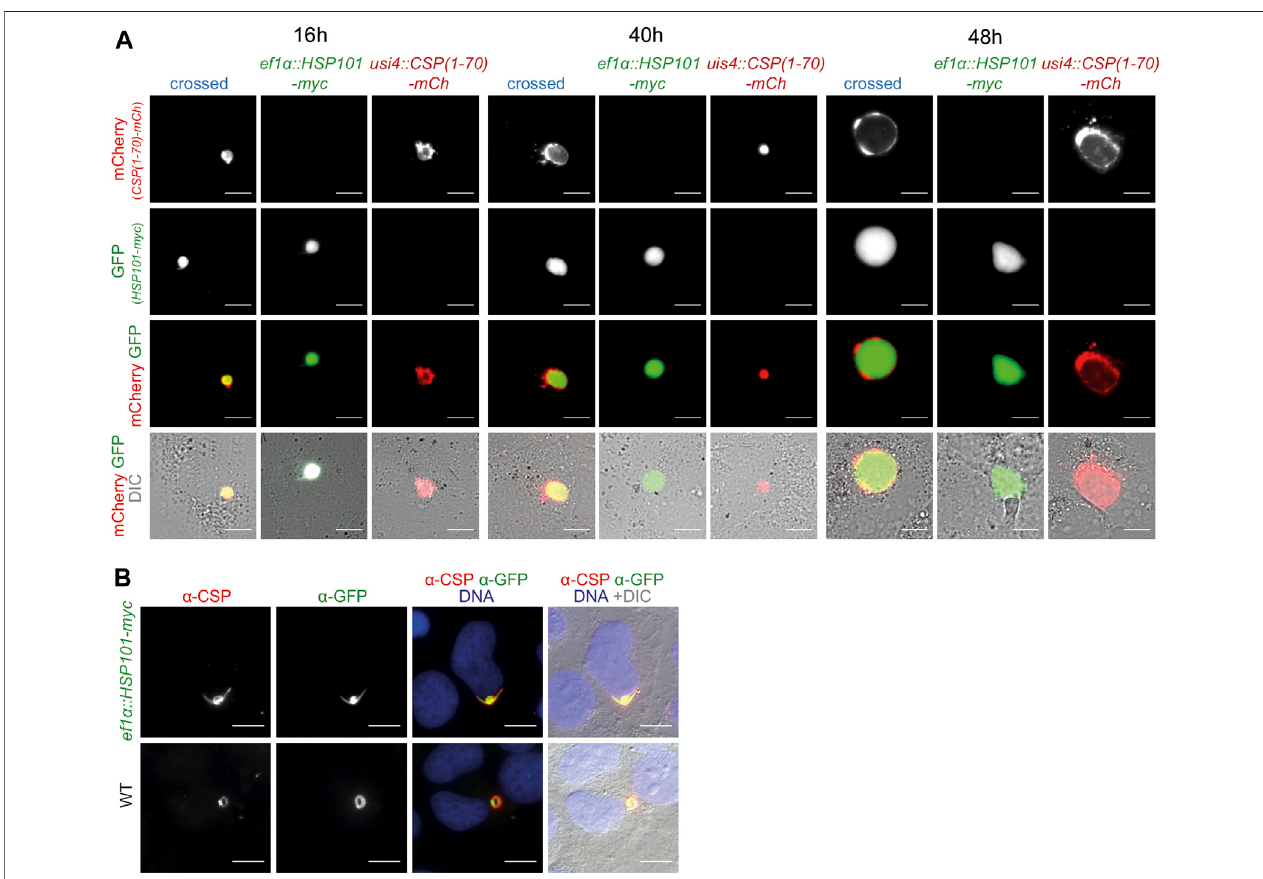
FIGURE 4 | Ecctopic expression of HSP101 in liver stages results in PV localization. (A) Live imaging of hepatoma cells infected with sporozoites from a genetic crossof ef1 α :HSP101-myc and UIS4:CSP-PEXEL-mCherry (crossed,blue),andthetwoindividualstrains, ef1 α :HSP101-myc (green), UIS4:CSP-PEXEL-mCherry (red). ShownarethePEXELmodelproteinfusedtomCherry (toprow, red),cytoplasmicGFPofthe ef1 α :HSP101-myc parasite (uppercenterrow, green),themergeofboth signals (lower center row) , and a merge of both fl uorescent signals with DIC images (bottom row) . Note that the mCherry-tagged model antigen remains con fi ned to the PV in HSP101-expressing parasites. Bars, 10 µm. (B) Immuno fl uorescence analysis of CSP in ef1 α :HSP101-myc (top row) and WT (bottom row) parasites,4 hafterinfection.Shownarethesignalsof α -CSP (left) and α -GFP (centreleft) ,themergeofbothsignalstogetherwithHoechst33,342(blue; centreright) , and a merge of all fl uorescent signals with DIC images (right) . Bars, 10